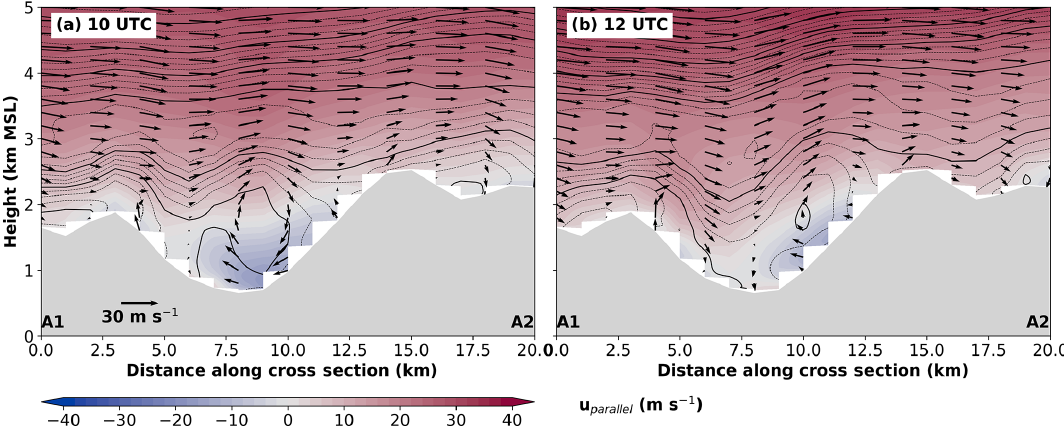
Figure 4. Vertical transect of simulated equivalent potential temperature (black contour lines: spacing 2K for thick solid lines and spacing 0.5K for thin dashed lines) and wind field (color contours and arrows) along cross section CS_CRINN at (a) 10:00UTC and (b) 12:00UTC on 29 October 2017. Color contours represent the horizontal wind component parallel to the plane (positive towards right), arrows illustrate the two-dimensional wind field on the vertical plane. Model topography is shaded in grey. A1 and A2 in (a) and (b) mark the start and end point of the transect as depicted in Fig.